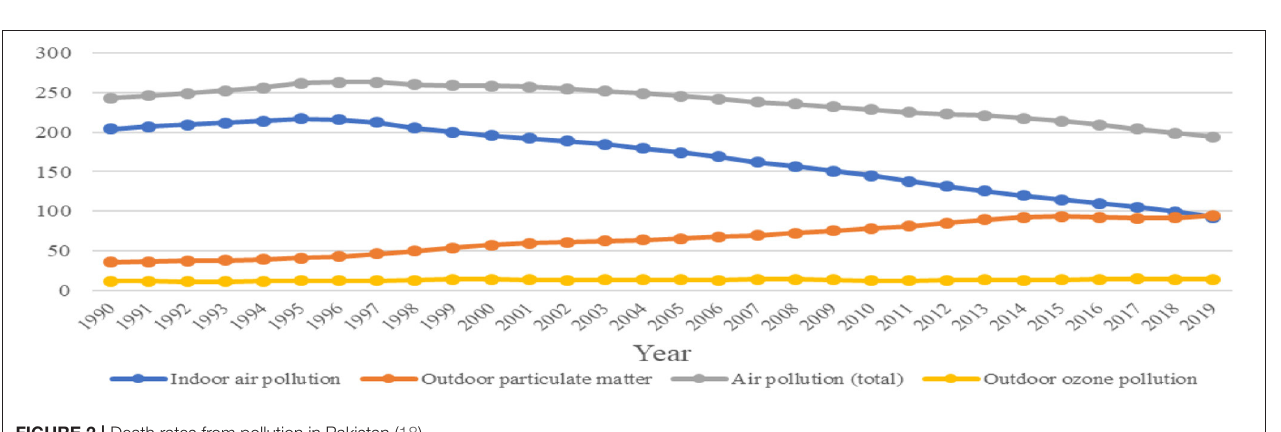
FIGURE 2 | Death rates from pollution in Pakistan